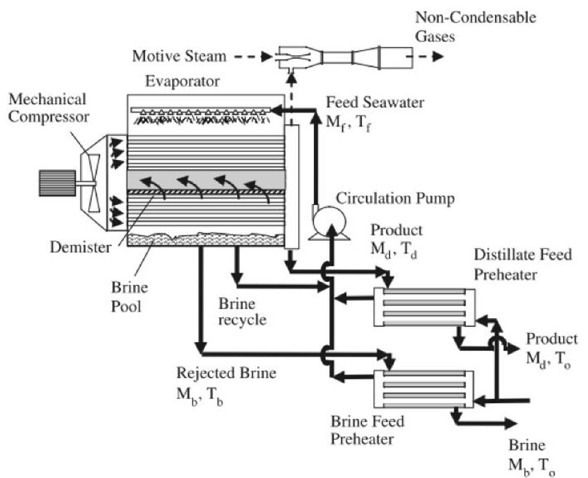
Fig. 18 Single-stage mechanical vapor compression (MVC) process (El-Ghonemy 2012)